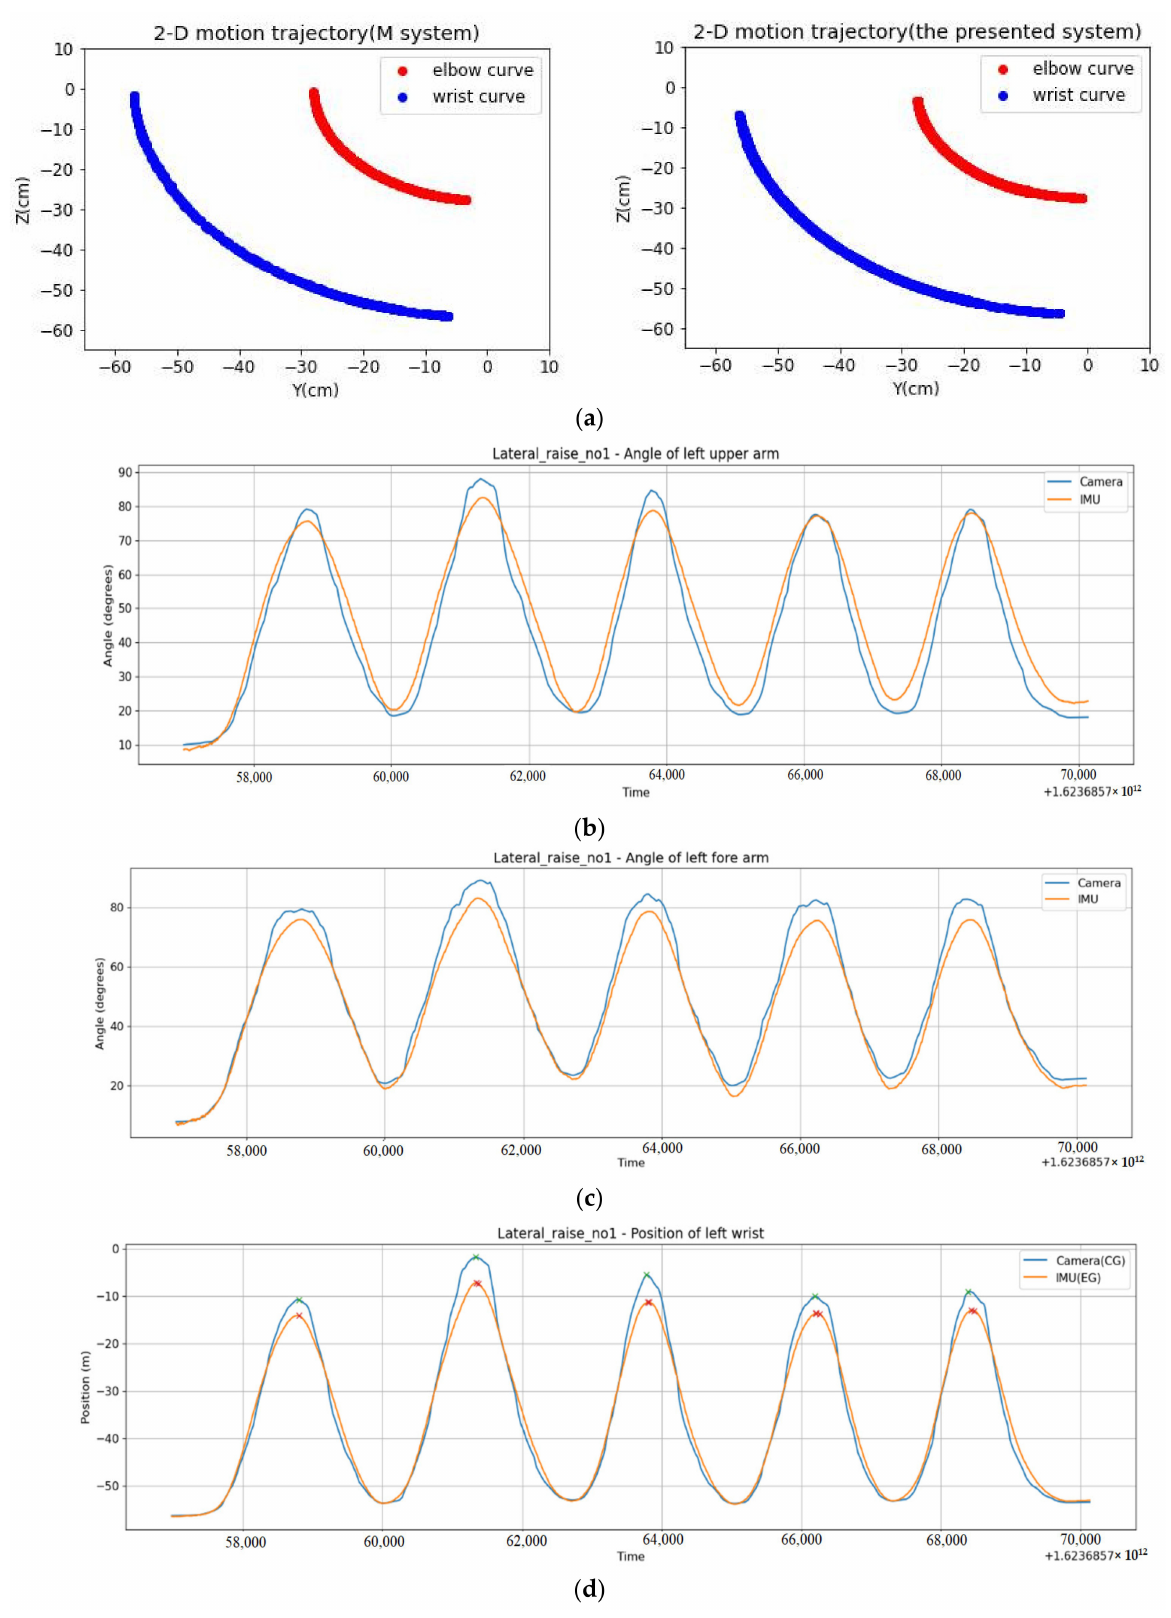
Figure 11. Comparison of the experimental results of the two motion tracking systems. ( a ) 2-D motion trajectory ( left : M system, right : the presented system); ( b ) curves for α ; ( c ) curves for β ; ( d ) curves for wrist